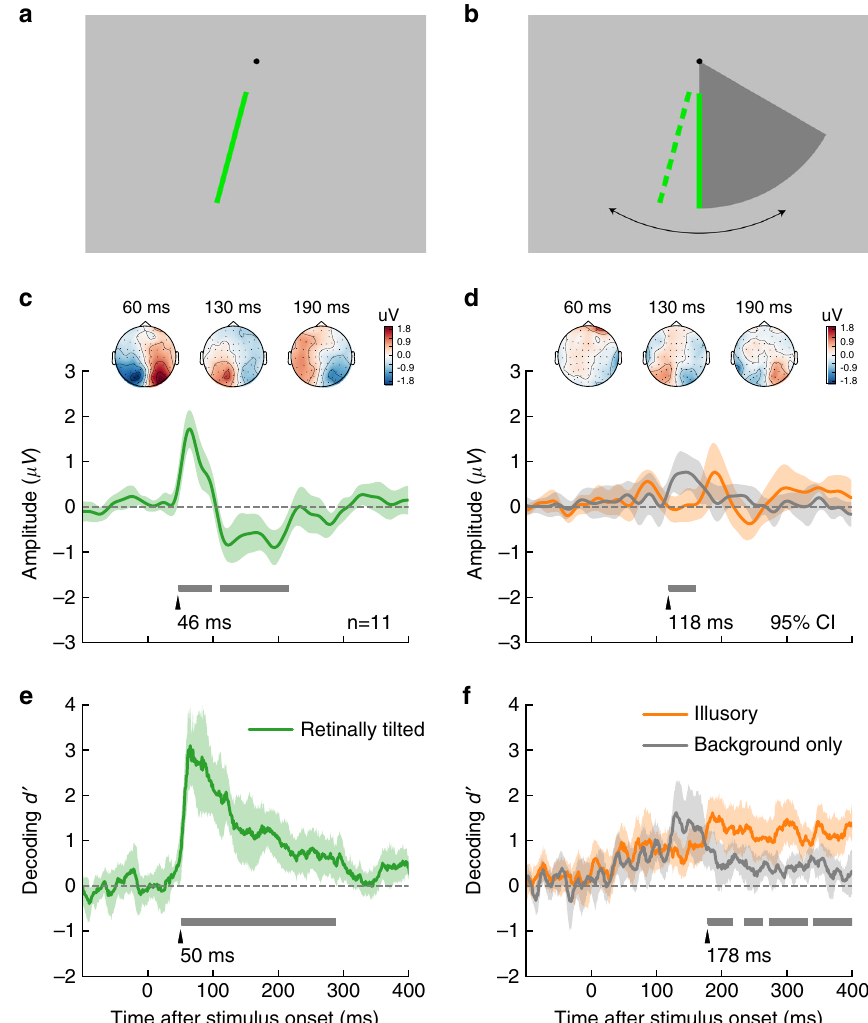
Fig. 4 Stimuli and results of the EEG experiment. a , b Visual stimulus and perception (dashed bar) in tilted bar only ( a ) and illusory ( b ) conditions. c , d The differential ERPs (contralateral minus ipsilateral) averaged over fi ve posterior electrodes and all subjects (n = 12 (individual subject)) in the tilted bar only (green), illusory (orange), and background-only (gray) conditions. Insets show corresponding topography snapshots in three diagnostic time points, assuming the bar fl ashed to the left of the vertical meridian. Note the topography in ( d ) corresponds to differential wave between illusory and background-only conditions. e , f Cross-validation performance of linear classi fi ers trained at each time point to predict to which side the bar was fl ashed (green), was perceived (orange), or would have been perceived if fl ashed (gray) averaged across subjects. Gray bars indicate the signi fi cant time period after multiple comparison correction ( p threshold = 0.05) Error bands indicate 95% con fi dence interval obtained by bootstrap. Source data are provided as a Source Data fi